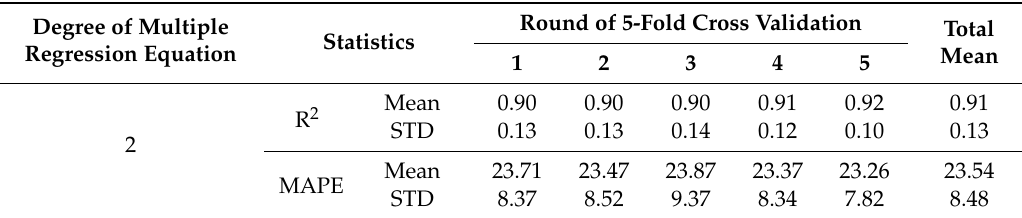
Table 11. Results of accuracy analysis of multiple regression analysis model for predicting morning ore production using training and validation